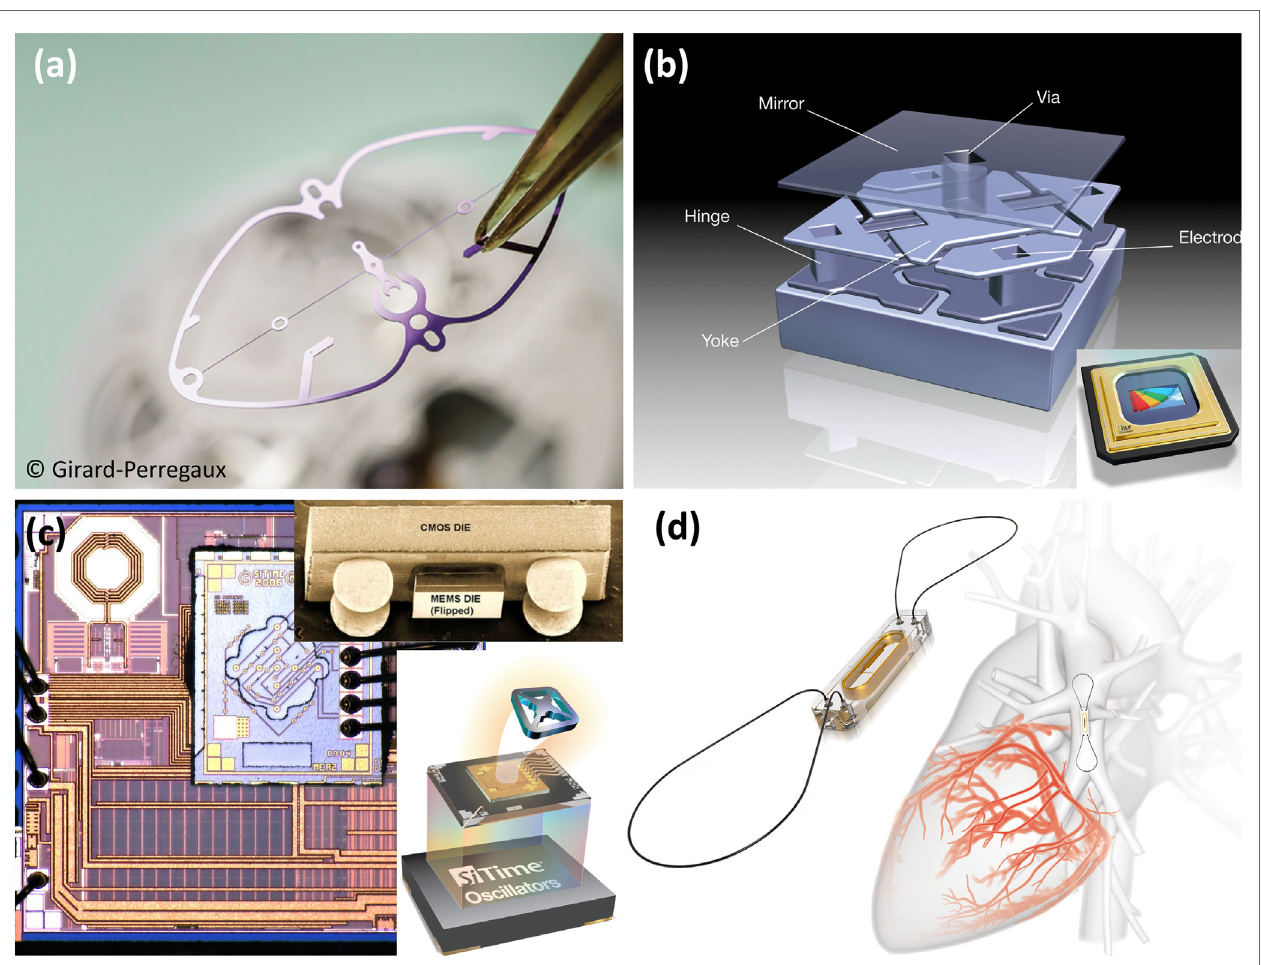
FiGUre 1 | commercial MeMS products. (a) Piece of a Swiss mechanical clock escapement fabricated in crystalline Si at CSEM Neuchatel, Switzerland. The high precision in manufacturing of this “ macro-MEMS ” implies much higher reproducibility and minimization of energy loss. Image courtesy of CSEM . (B) Schematic of a Texas Instruments (TI) Digital Light Processor (DLP) that has been powering since 1996 the world’s top display devices to deliver high-resolution images. Every DLP chipset (see inset on the bottom-right corner) features an array of microscopic mirrors that switch on and off up to 10,000 times per second. Image courtesy of TI. (c) Main - Optical microscope image of a SiTime MEMS-based oscillator, which includes a CMOS chip with the feedback circuitry and a separate chip on top with the self-packaged resonator. These oscillators are used as time references and frequency sources, and in some applications where miniaturization is paramount they have started replacing the more conventional quartz-based oscillators. Inset top-right – SEM micrograph of a newer generation where the MEMS is flip-chip bonded on the CMOS die, which is in turn ready to be flip-chip bonded on the PCB. Inset bottom-right – Cartoon showing the three levels of packaging of the SiTime oscillators – SMD level, two chips assembly, and mechanical device. Image courtesy of SiTime. (d) CardioMEMS HF System from St. Jude Medical (SJM). The system consists of a small pressure sensor (left) that can be implanted in the pulmonary artery (right) and it is powered externally via a RF signal. The sensor monitors the internal pressure in the pulmonary artery, which has been correlated to heart failure, therefore representing a major step in personalized medicine. Image courtesy of St. Jude Medical